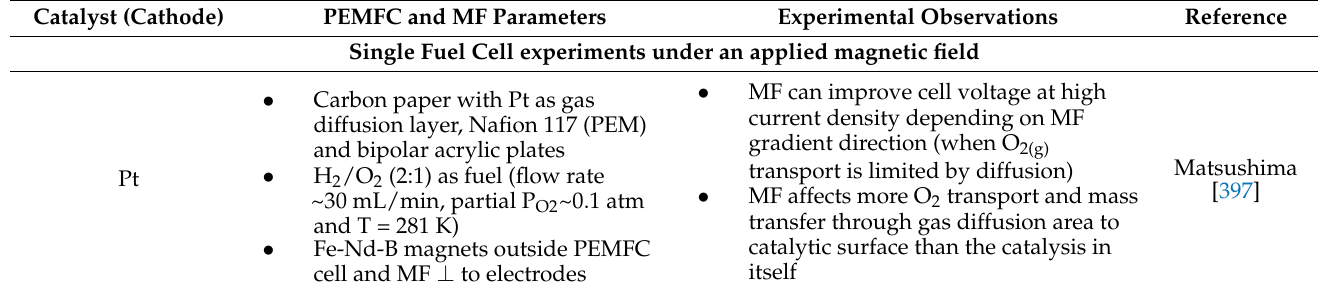
Table 9. PEMFC parameters and experimental observations in applied experiments carried out in the presence of an external magnetic field or magnetic catalysts. MF and RH stand for magnetic field and relative humidity,